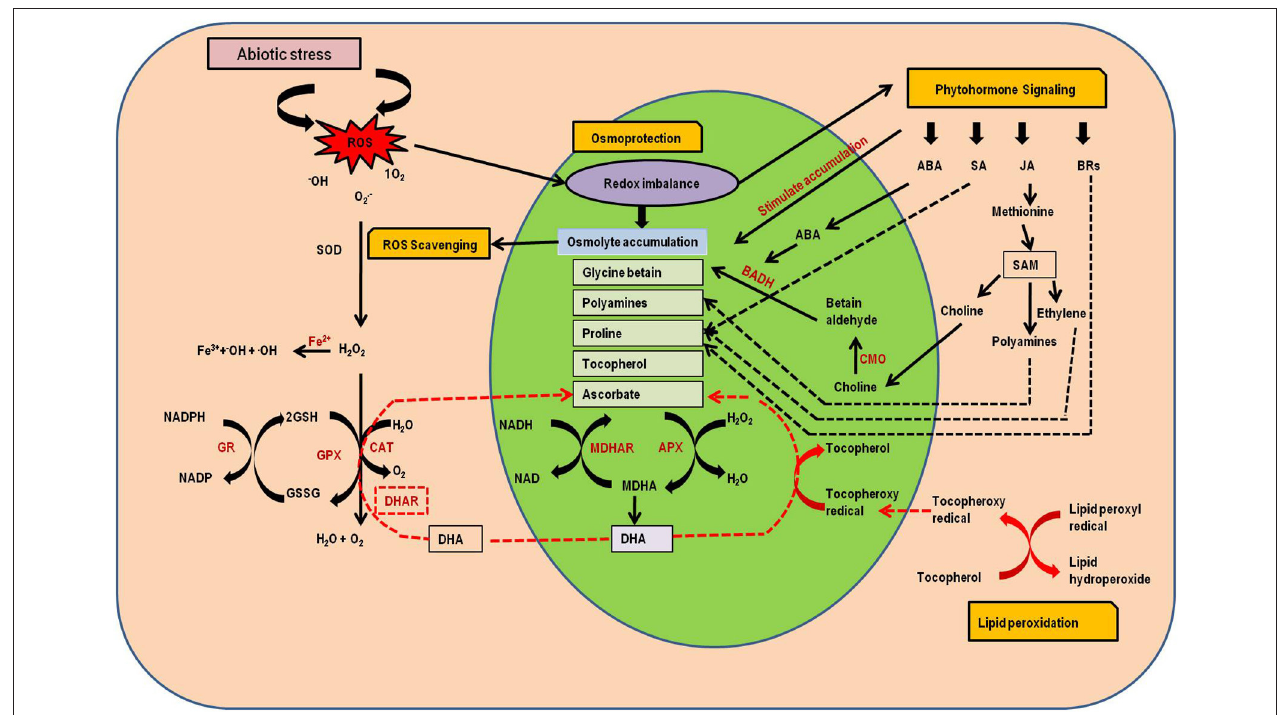
FIGURE 3 | Schematic representation of antioxidant defense mechanisms against several abiotic stresses in plant. A series of redox coupled reactions with some important signaling pathways including osmoprotection by osmolyte accumulation, ROS scavenging, lipid peroxidation and phytohormonal signaling pathways are presented. BADH, betain aldehyde dehydrogenase; CMO, cholin monooxygenase; SAM, S-adenosylmethionine; GSSG, glutathione disulphide; CAT, catalase; GSH, glutathione; GR, glutathione reductase; DHAR, dehydroascorbate reductase; MDHAR, monodehydroascorbate